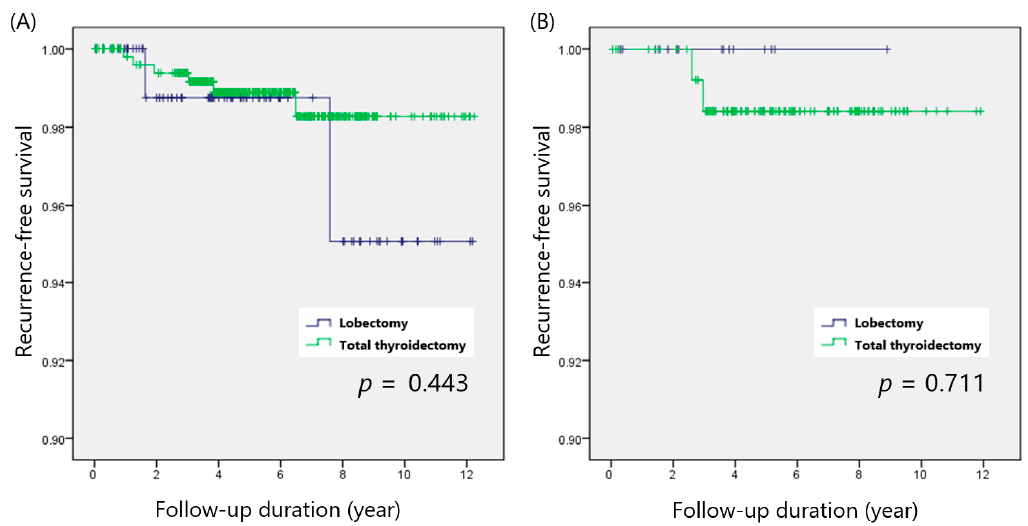
Figure 2. Recurrence-free survival in patients with ( A ) PTMC and ( B ) non-PTMC. There were 490 patients with node-negative PTC, and LN metastasis was diagnosed in 225 patients. In the node-negative group, recurrences were observed in 2 of 404